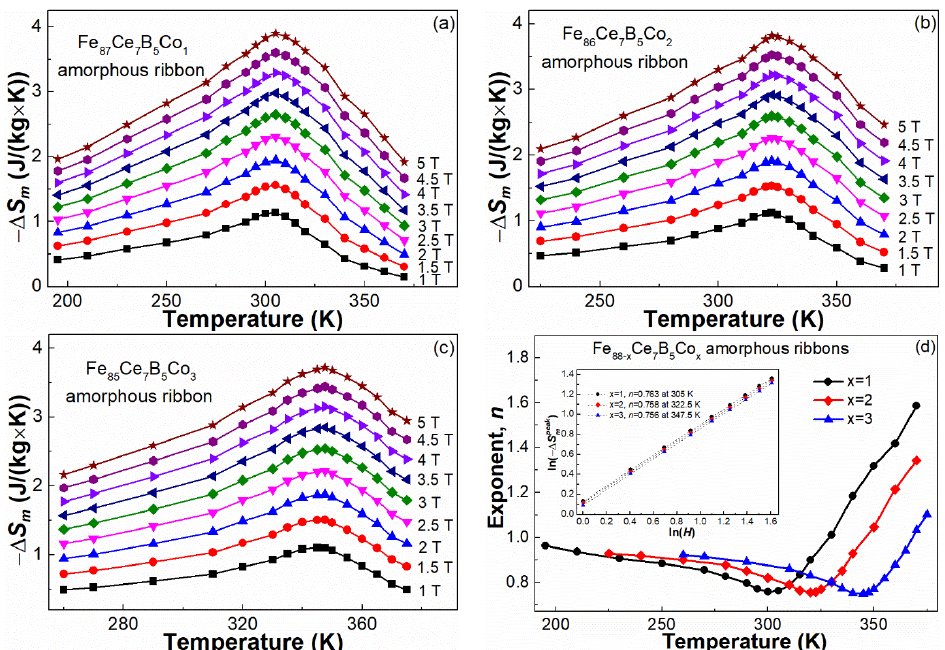
Figure 4. ( −Δ S m )- T curves of the Fe 88- x Ce 7 B 5 Co x amorphous ribbons under various magnetic fields: ( a ) x = 1, ( b ) x = 2, ( c ) x = 3, and ( d ) n - T curves of the Fe 88- x Ce 7 B 5 Co x amorphous ribbons; the inset is the ln( −Δ S mpeak )-ln( H ) plots of these ribbons at T c . Table 2. −Δ S mpeak and T c of some Fe-based amorphous alloys near room temperature. −Δ S mpeak (J/(kg×K)) Composition